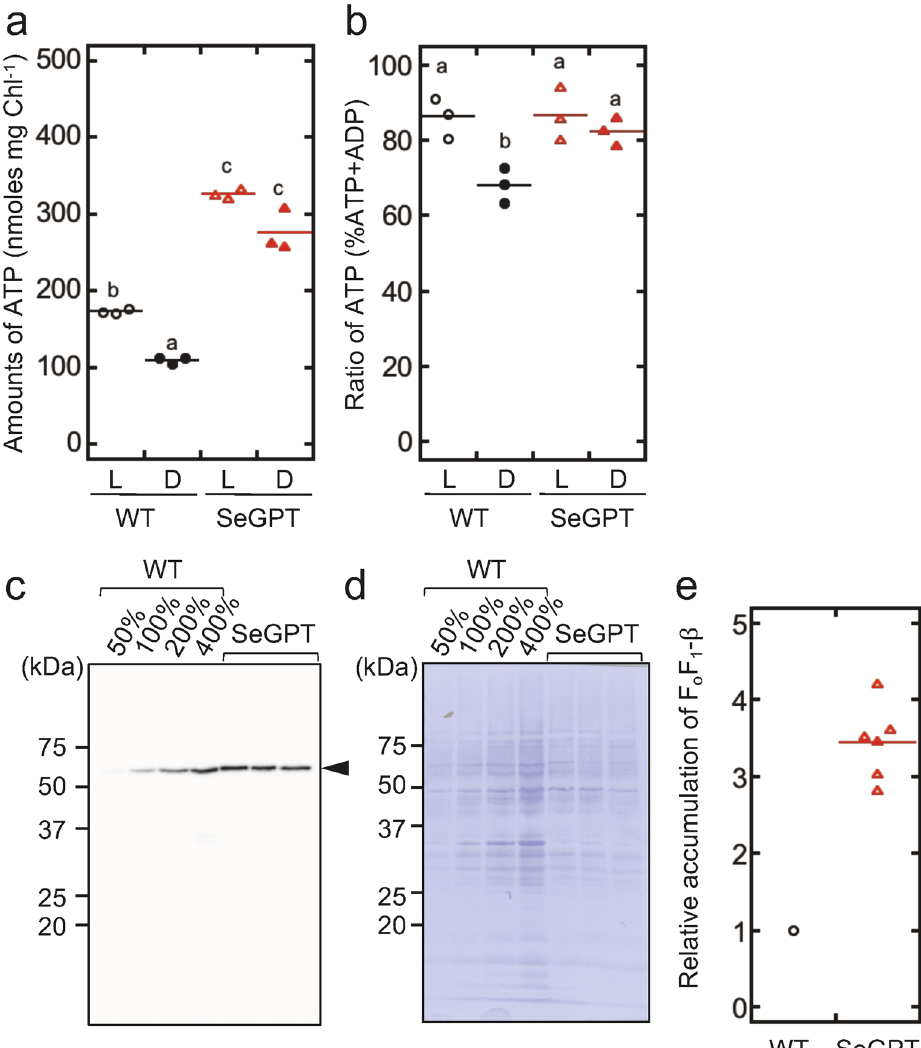
Figure 4. Measurements of intracellular ATP (and ADP) contents ( a , b ), and the quantification of F o F 1 -ATP synthase accumulation via immunoblot analysis using β-subunit antibodies ( c – e ). ( a ) Steady-state intracellular ATP content normalized to chlorophyll content. ( b ) The ratio of ATP/ATP + ADP. Cells were grown under continuous illumination (L), after which they were subjected to dark treatments for 15 min (D) and fixed with 2% (w/v) perchloric acid. After neutralization, ATP (or ATP + ADP) in the supernatant was quantified using a luciferin–luciferase assay. Different letters indicate significant differences ( p < 0.05; Tukey–Kramer multiple comparison tests). For the quantification of ATP + ADP, prior to the luciferin–luciferase assay, neutralized aliquots were incubated for 3 h at 25 °C in the presence of pyruvate kinase. ( c , d ) Immunoblot analysis using the F o F 1 -β antibodies ( c ) and CBB-stained membrane ( d ) in the membrane fractions of the WT and SeGPT. Thylakoid membrane proteins equivalent to 0.75 µg chlorophyll were loaded for 100% WT and SeGPT. Three extracts from independent experiments were loaded for SeGPT. Full-length images are shown in Fig. S6. ( e ) Relative accumulation in SeGPT was calibrated according to that of the